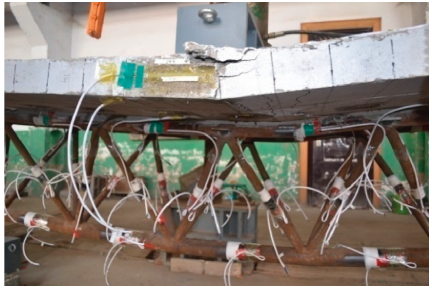
Figure 4: Failure mode of the composite